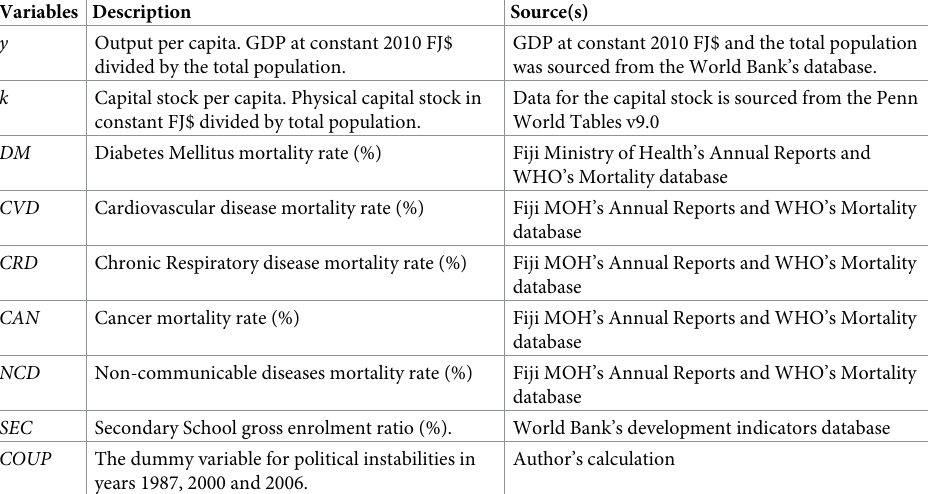
Table 1. Data definition, description and sources.